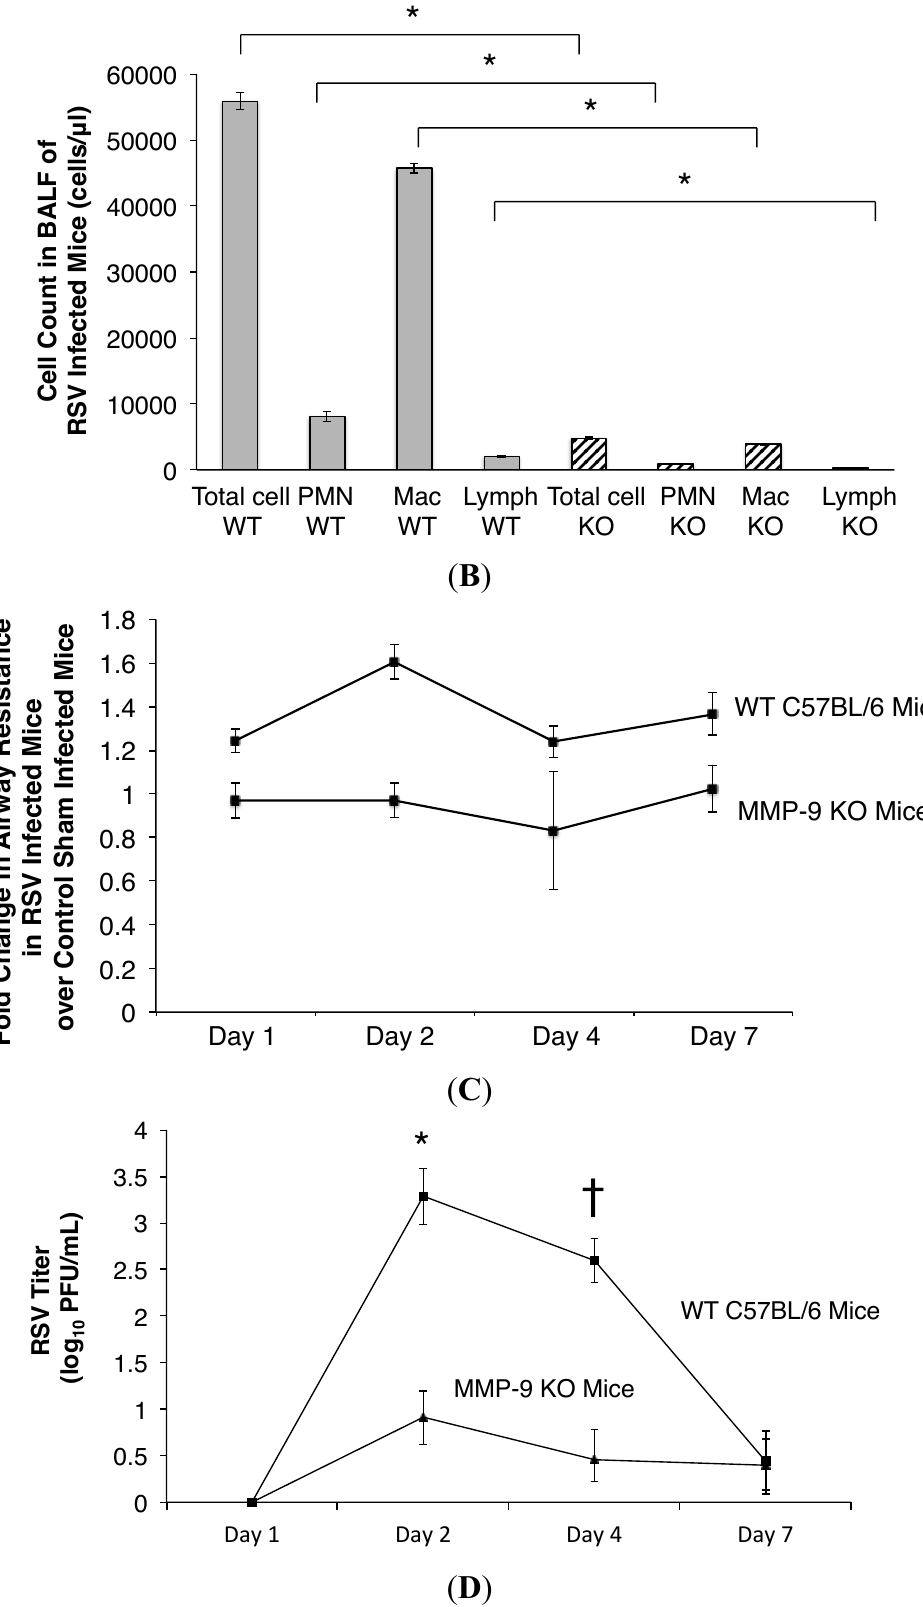
Figure 4. ( A ) Lung inflammation in RSV infected WT and MMP-9 KO mice. WT and MMP-9 KO C57BL/6 mice received the same quantity of RSV inoculum. Tissue was stained with hematoxylin and eosin to assess lung inflammation post RSV infection. Acute pneumonitis with perivascular and peribronchial inflammatory infiltrates was observed in the RSV infected WT animals on days 2 PI ( vs . normal lung histology in mock infected WT controls). In contrast, minimal lung inflammation was noted in the RSV infected